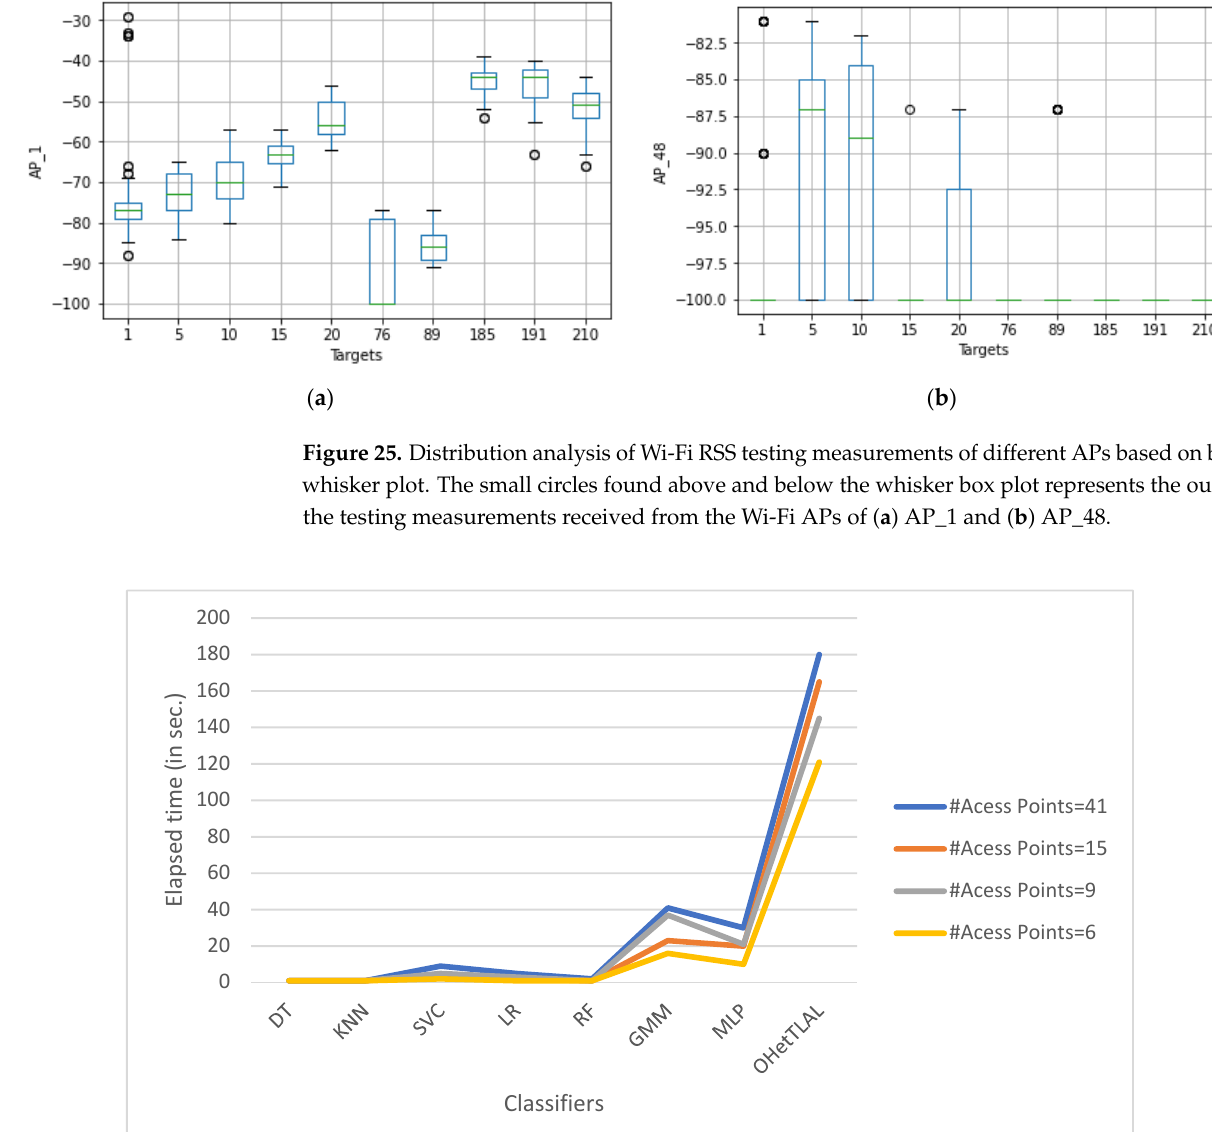
Figure 24. Distribution analysis of Wi-Fi RSS training measurements of different APs based on box and whisker plot. The small circles found above and below the whisker box plot represents the outliers of the training measurements received from the Wi-Fi APs of ( a ) AP_1 and ( b ) AP_48.